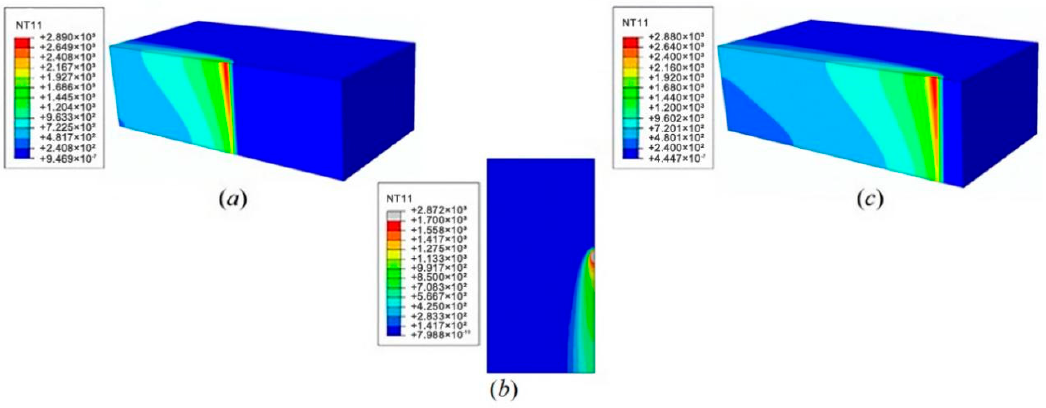
Figure 8. Temperature field distributions ( a ) on the weld surface when t = 6 s, ( b ) in the direction perpendicular to the weld when t = 6 s, and ( c ) on the weld surface when t = 10 s.